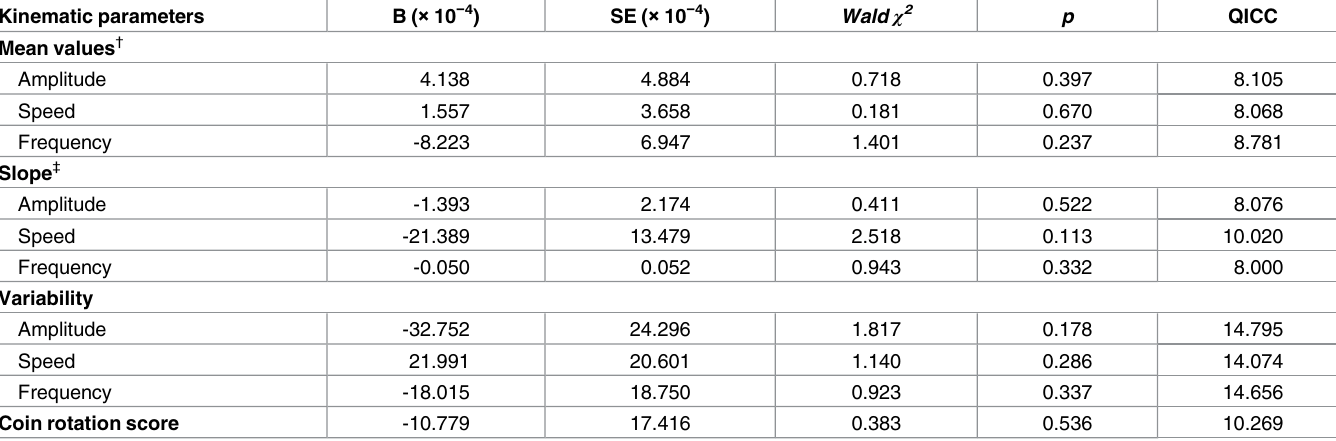
Table 4. Impact of TDT prolongation on kinematic parameters of finger tapping in the control group. Kinematic